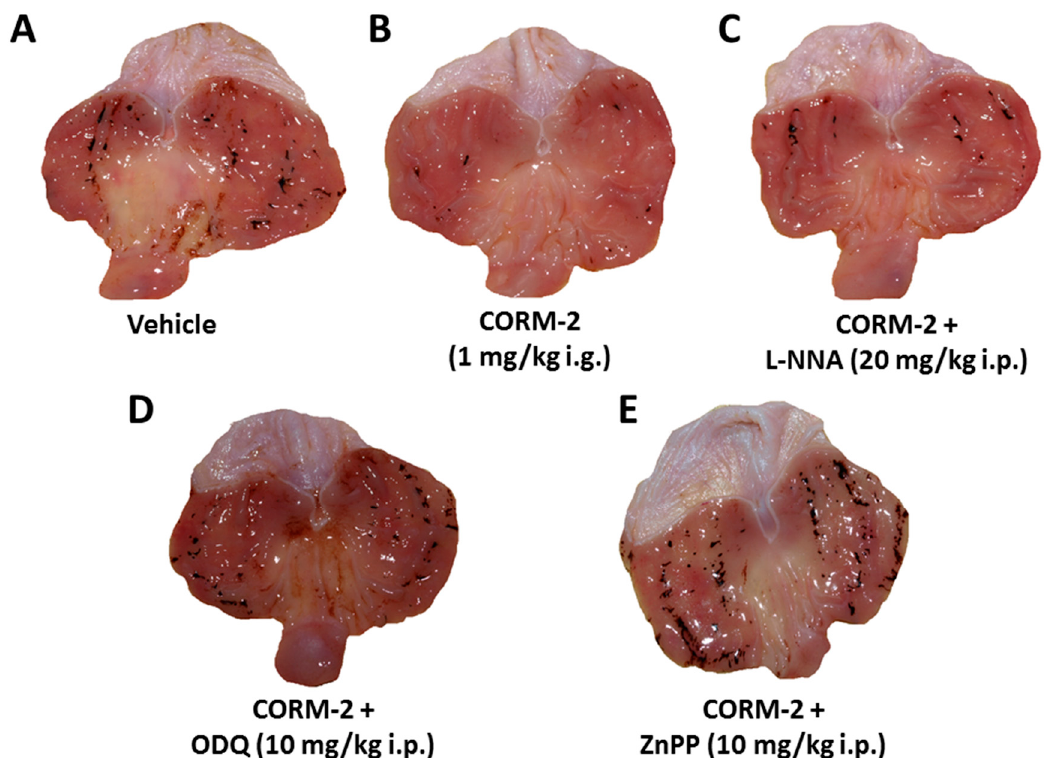
Figure 5. Gastric mucosa of rats exposed to water immersion and restraint stress (WRS) pretreated with vehicle (saline; i.g.) ( A ); Carbon monoxide releasing molecule 2 (CORM-2, 1 mg/kg i.g.) applied alone ( B ); or in combination with N G -nitro- L -arginine ( L -NNA, 20 mg/kg i.p.) ( C ); 1H-[1,2,4]oxadiazolo[4,3-a]quinoxalin-1-one (ODQ, 10 mg/kg i.g.) ( D ); or zinc protoporphyrin IX (ZnPP, 10 mg/kg i.p.) ( E ). Note, the presence of hemorrhagic gastric lesions in the gastric mucosa of rats pretreated with vehicle (control) and exposed to 3.5 h of WRS ( A ). These macroscopic lesions were reduced by CORM-2 ( B ) were not affected by concurrent treatment of L -NNA ( C ) but increased in CORM-2-pretreated rats concomitantly treated with ODQ ( D ) or ZnPP ( E ).